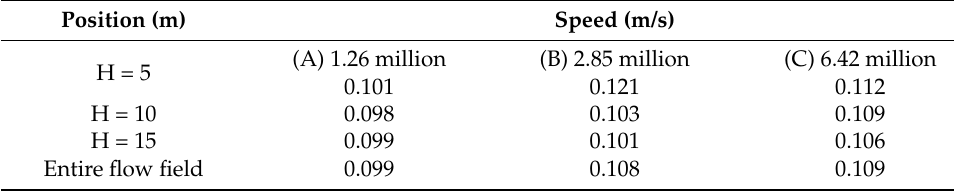
Figure 5. ( A ) Coarse grid, ( B ) medium grid, and ( C ) fine grid. Table 1. Average velocity results at different locations. Table 1. Average velocity results at different